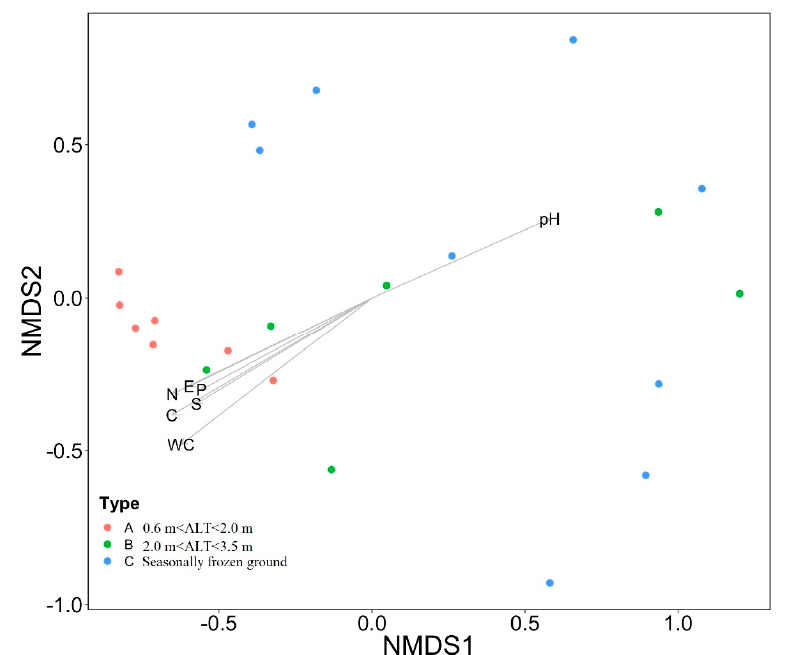
Figure 6. Non-metric multidimensional (NMDS) plot for the vegetation composition, with linear vectors of environmental factors (K = 2, Stress = 0.16). Note: Active layer thicknesses (ALTs) were grouped in three ranges: A, 0.6 m < ALT < 2.0 m; B, 2.0 m < ALT < 3.5 m; and C, seasonally frozen ground. Data were collected at 22 sites, with three replicates per site, and averaged for each site. The direction of the linear arrow refers to environmental gradient. Additionally, the length of vector represents the prediction of power. WC, soil water content; EC, electrical conductivity; E, Elevation; C, soil total carbon; N, soil total nitrogen; P, soil total phosphorous.